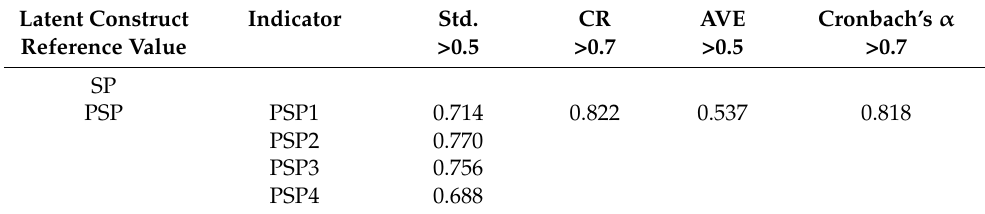
Table 3. Results of reliability and validity